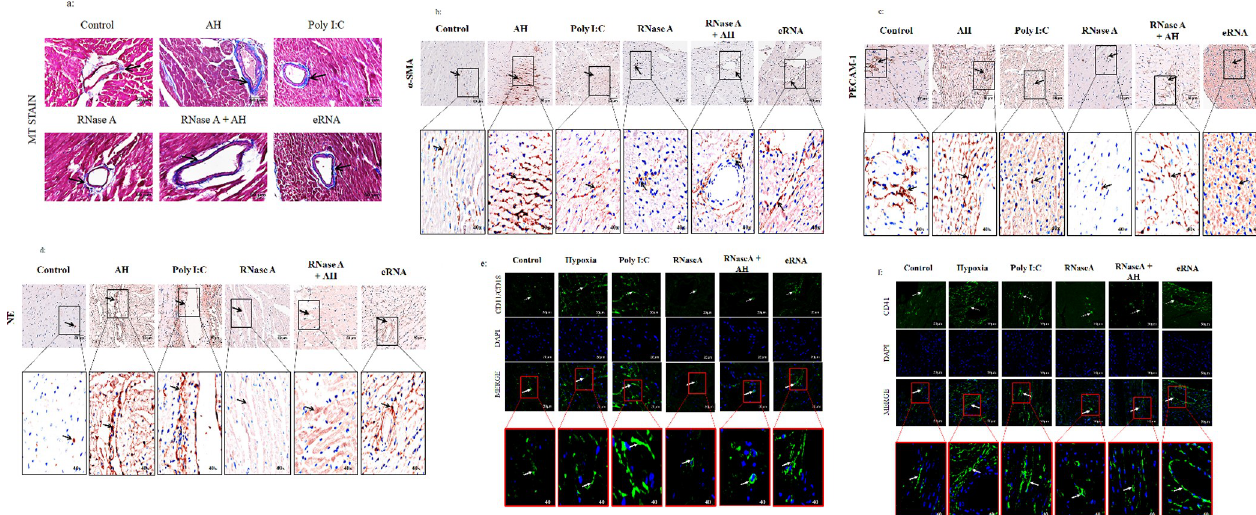
Fig 5. Hypoxia induced eRNA stimulates collagen accumulation, leucocyte infiltration and activation in cardiomyocytes. (a) MT staining (Collagen stained purple whereas tissue was stained pink); immunohistochemistry/immunofluorescence analysis of (b) α -SMA, (c) PECAM-1, (d) NE, (e) CD11/CD18 and (f) CD41 in myocardial tissue sections have been presented with higher magnification images in the subset. Magnification of the images in subset is 40X. Images were acquired at 20X and 40X resolution. DAPI (blue) was used as a nuclear stain. Data are representative of three independent times with three mice per experiment. (Scale bar: 50 μ